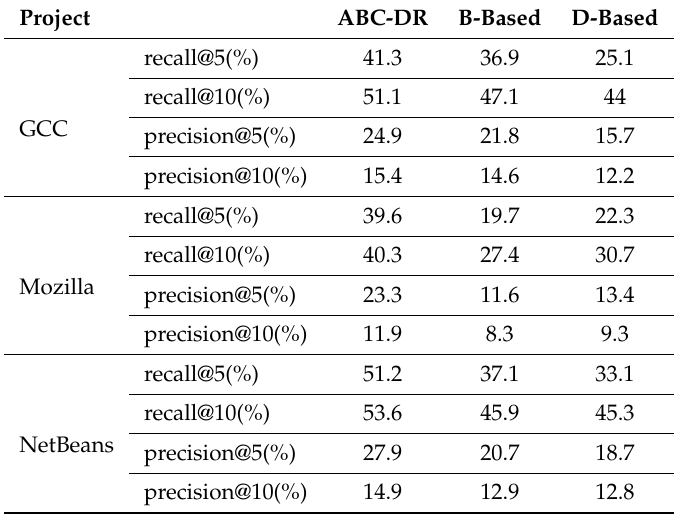
Table 5. recall@5, recall@10, precision@5, and precision@10 of our proposed ABC-DR and B-based component (B-based) and D-based component